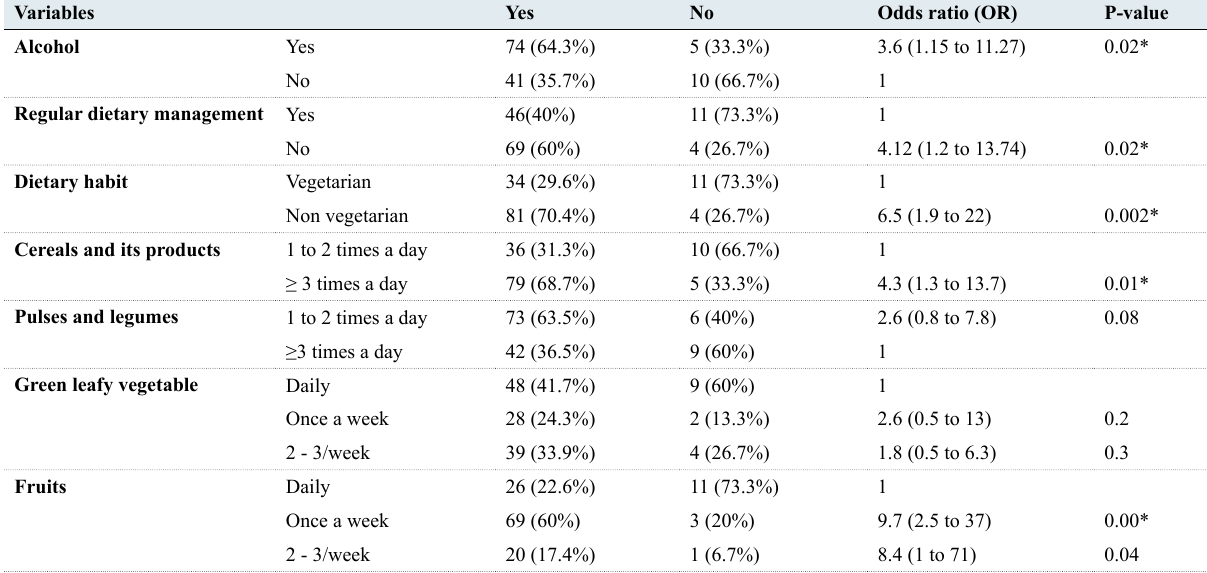
Table 3A: Eating behavior and its association with dyslipidemia in